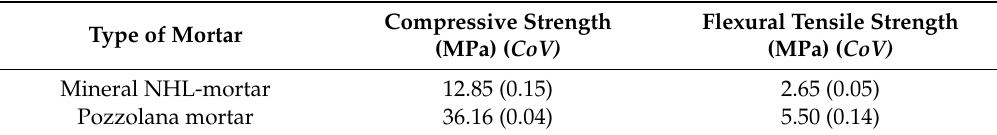
Table 3. Mechanical properties of the matrix.